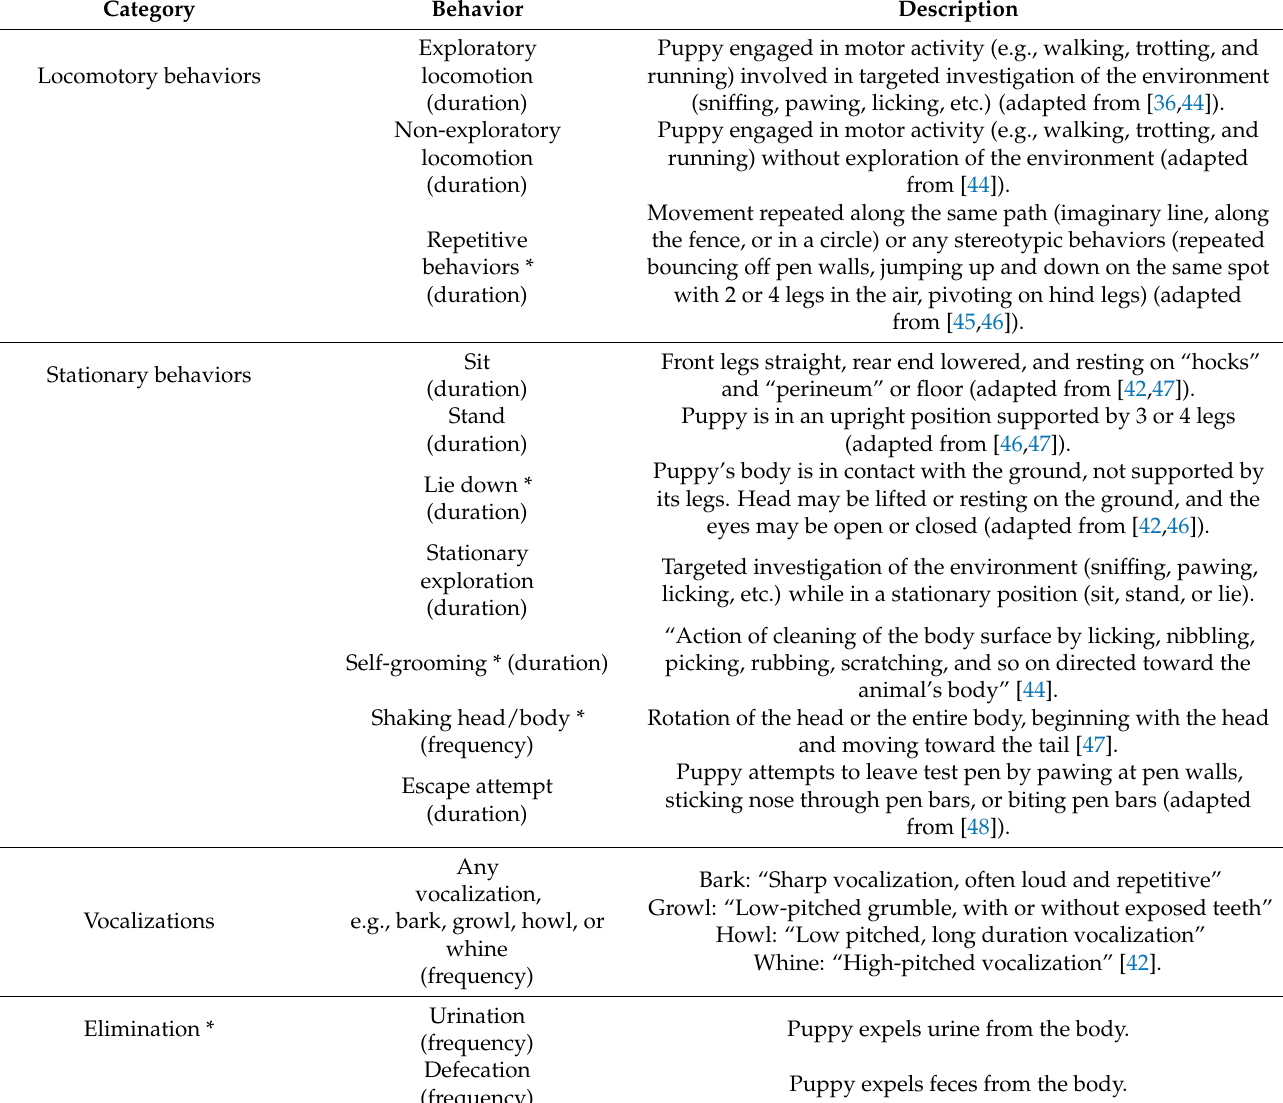
Table 3. Ethogram used for isolation video